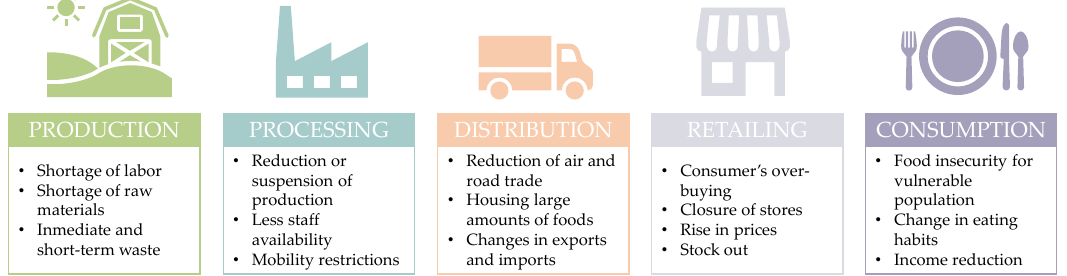
Figure 1. Food sector challenges caused by COVID-19 that directly or indirectly affect FLW genera- tion.